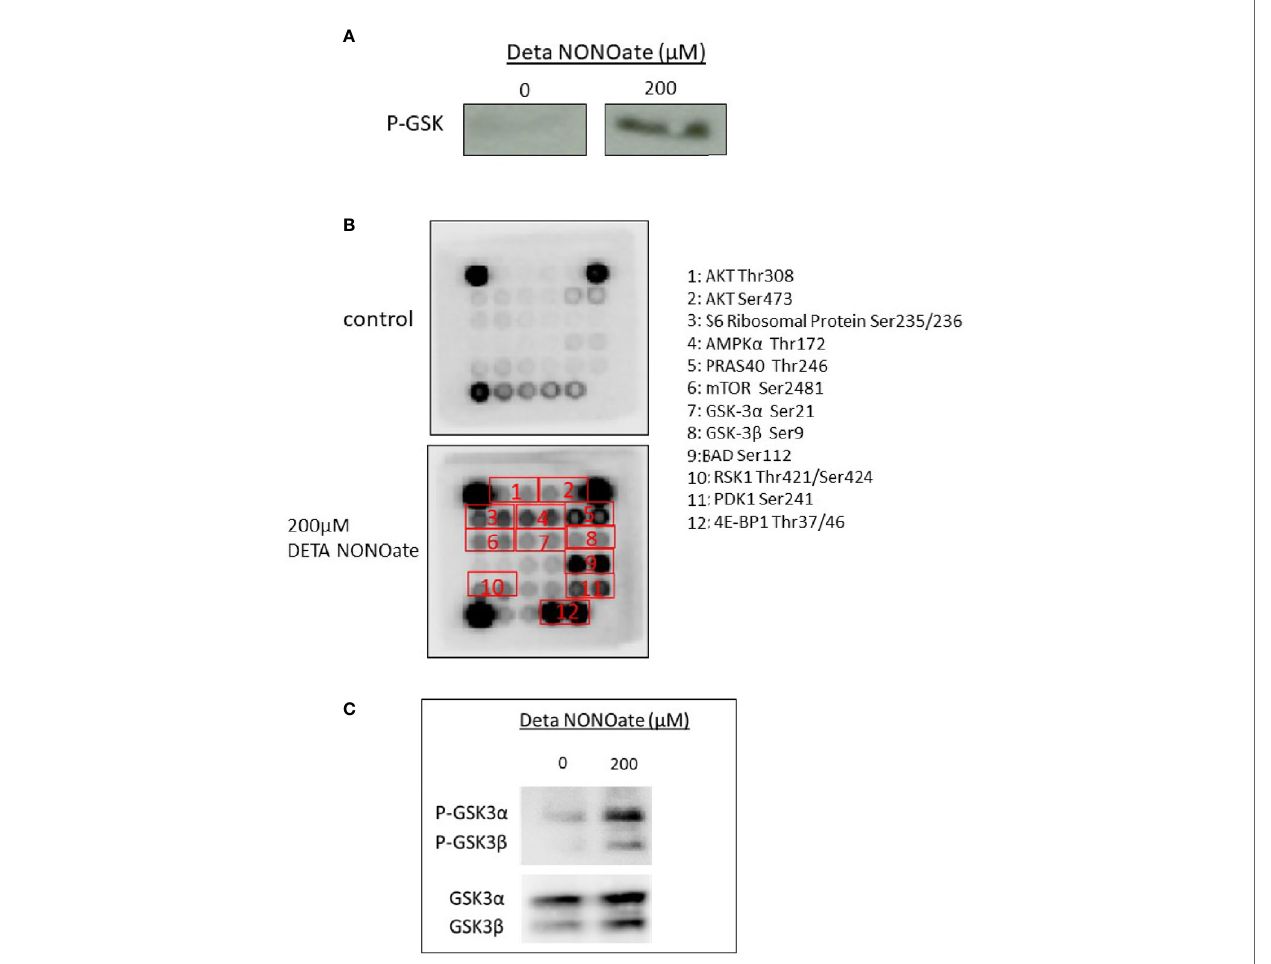
FIGURE 3 | AKT activation increases phosphorylation in the AKT pathway targets. (A) AKT kinase activity was measured by AKT immunoprecipitation from cell extracts, followed by an in vitro kinase assay using GSK-3 fusion protein as a substrate. Phosphorylated GSK-3 levels in A375 cells treated with 200 m M DETA NONOate for 2 h. were measured by Western blotting. (B) Phosphorylation of AKT pathway targets after 2 h. of treatment with 200 µM DETA NONOate. The protein phosphorylation of 16 AKT pathway targets was examined using the antibody assay kit. Of the 16 AKT pathway targets, 12 showed increased phosphorylation after DETA NONOate treatment. (C) Western blotting was used to validate the GSK-3 a and GSK-3 b phosphorylations in A375 cells treated with 200 m M DETA NONOate for 2